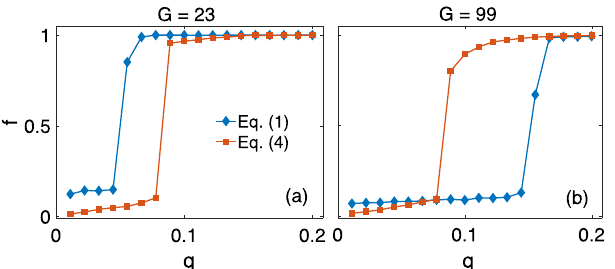
Figure 4. Limit of large Q. Comparison of the presented model in Eq. (1) and the one in Eq. (4) that q Q / N � , where Q is the number of actually updated resembles 40 . The coupling, g , is chosen to be g = ≡ triads; N (cid:31) is the total number of triads. Results are averaged over 100 independent runs for N 360 , and G 23 (a) ; G 99 N (cid:31) = = =